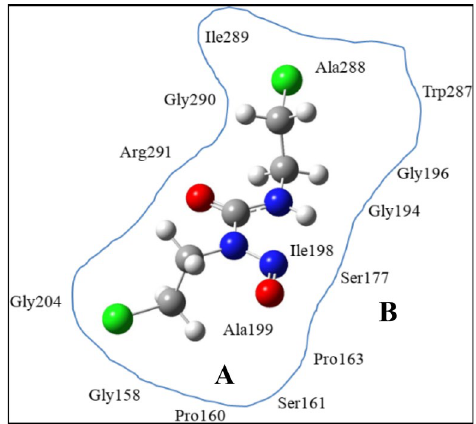
Figure 1. Schematic 2D diagram of the model system carmustine bound to GR binding site. Layers that are partitioned are shown for ONIOM calculations. A is the inner layer (QM calculations) and B is the outer layer (MM calculations). The arrangement of the residues is shown in 2D diagram is not their actual position in